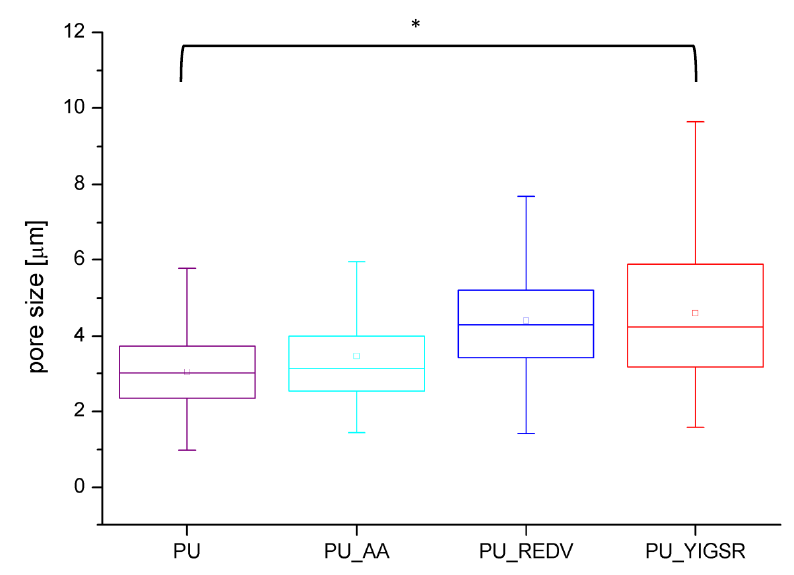
Figure 2. Pore size distribution for obtained materials (n = 100), *: p < 0.05.